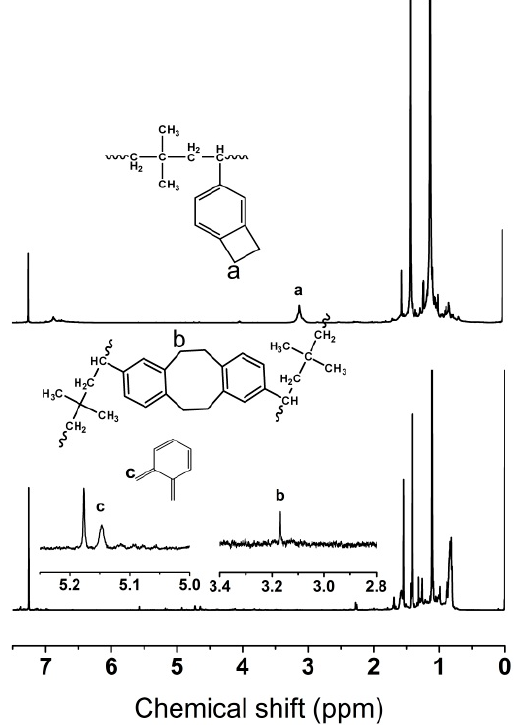
Figure 6. 1 H NMR spectra of the copolymer before thermal crosslinking ( top ) and after thermal crosslinking ( bottom ).